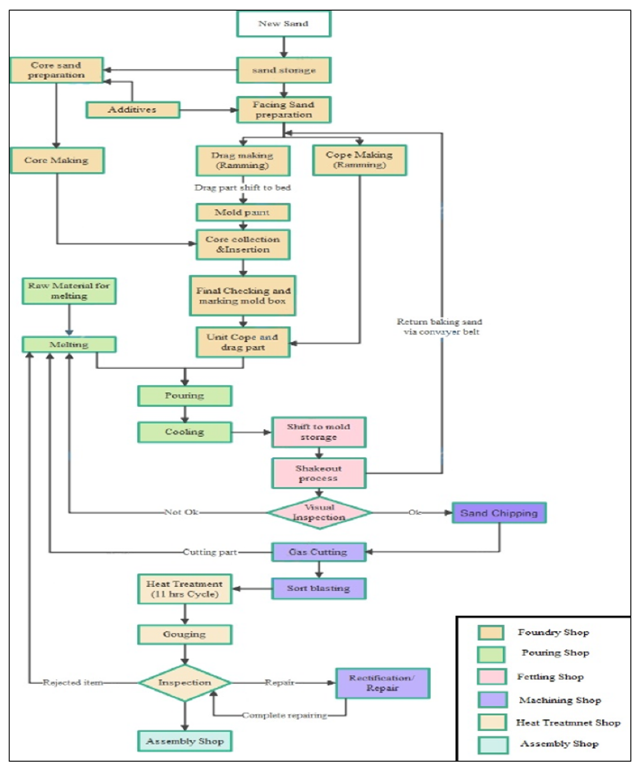
Fig. 4. Existing layout of shop